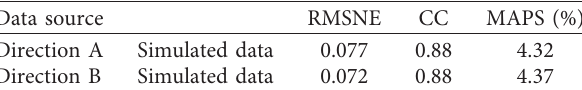
Figure 10: Comparative review of the realized values of the travel time and the values obtained in the model and differences between the two, by hours in a day, for direction B. Table 9: Deviation of the simulated values of PT vehicles’ travel time from the real values of PT travel